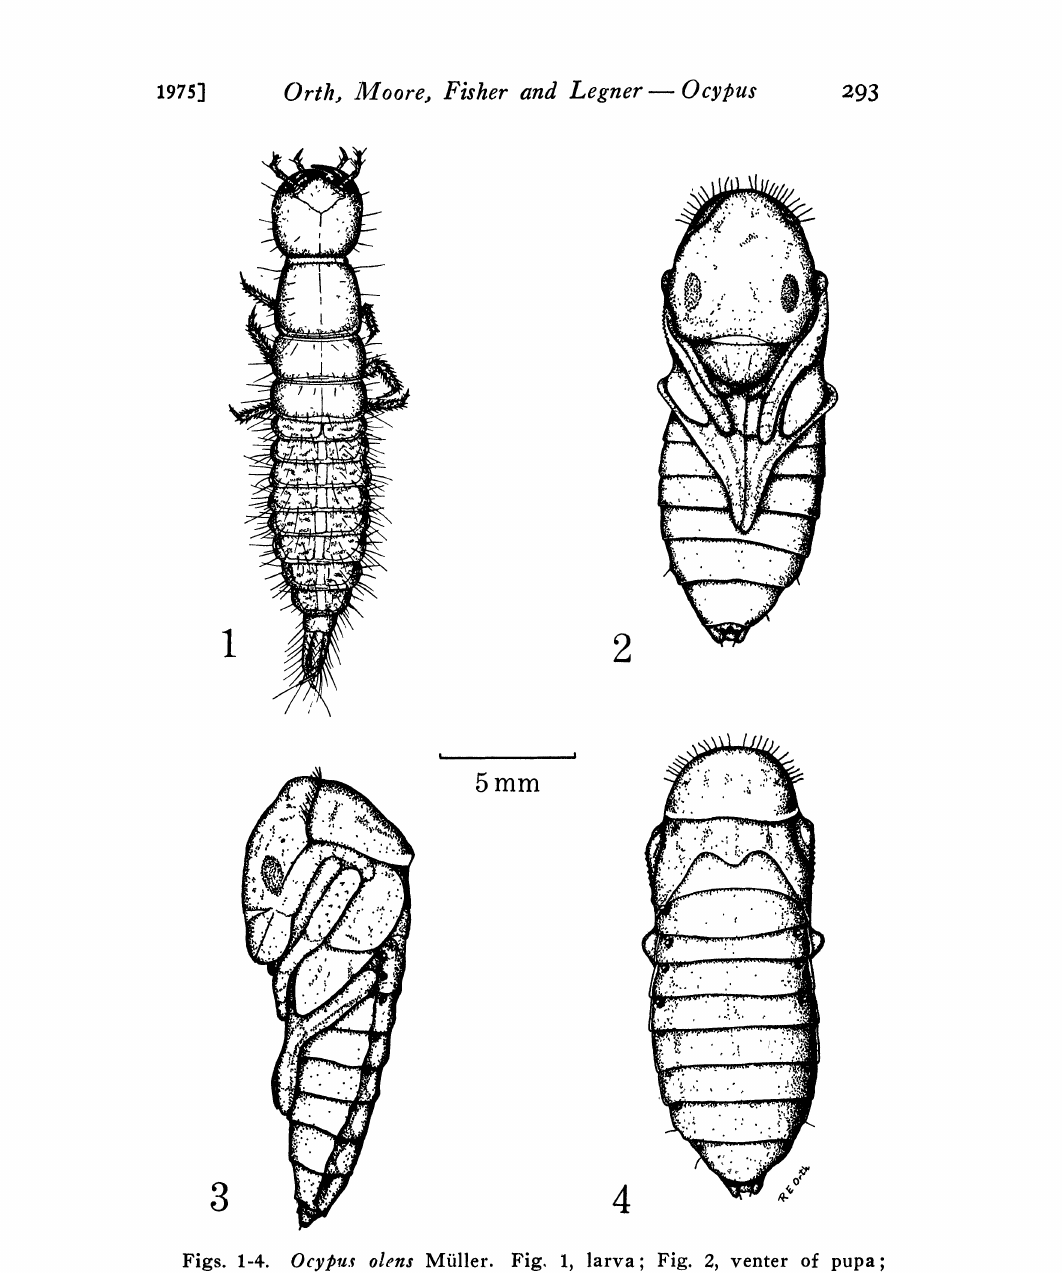
Figs. 1-4. Ocypus olens MOiler. Fig. 1, larva; Fig. 2, venter of pupa; Fig. 3, side of pupa; Fig. 4, dorsum of